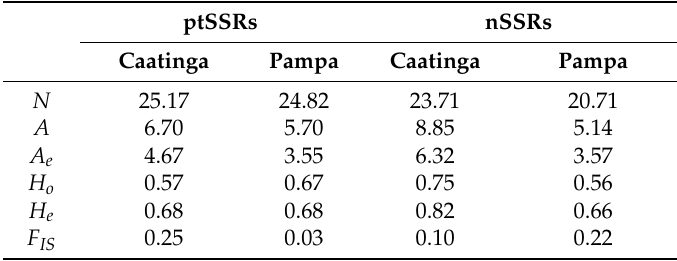
Table 3. Mean values of genetic parameters estimated for Schinus molle based on the 24 SSR markers characterized in this study. Data are presented independently for each genomic region, plastidial (ptSSRs) and neutral nuclear (nSSRs), for each population. Estimations include the number of samples ( N ), number of alleles per locus ( A ), effective allele number ( A e ), observed ( H O ) and expected ( H E ) heterozygosities, and within-population fixation index ( F IS ).